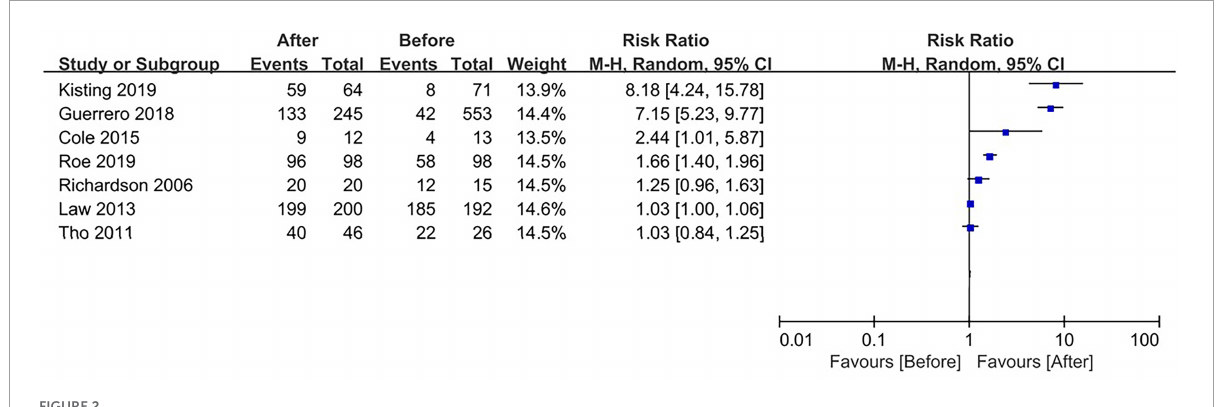
FIGURE2 Forest plot for the effect of the implementation